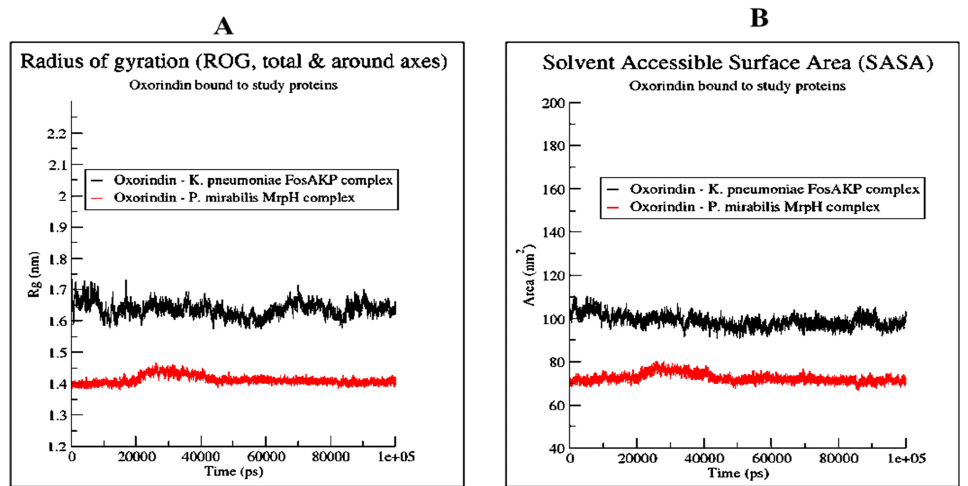
Figure 5. ( A ) Radius of gyration, and ( B ) solvent accessible surface area of Oroxindin in complex with 5WEW and 6Y4F .